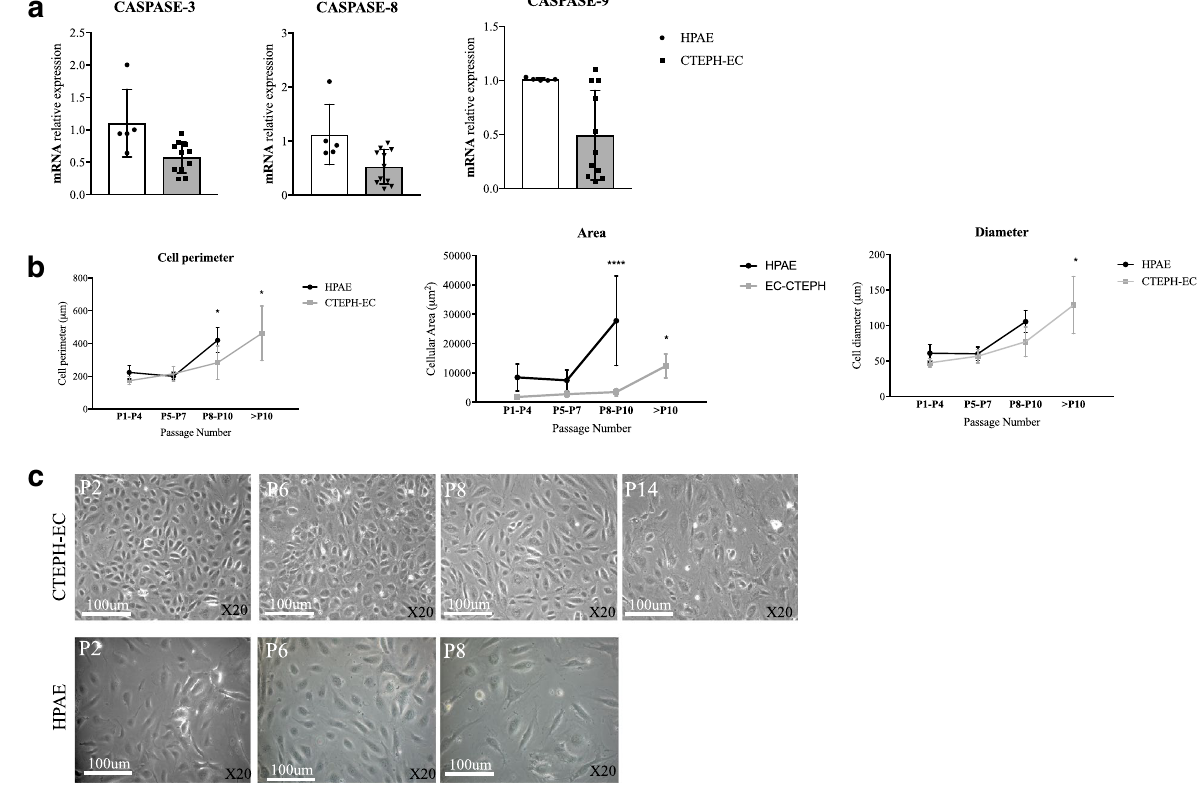
Figure 5. Apoptosis in CTEPH-EC. ( a ) mRNA expression profile of apoptotic markers caspase-3, -8 and -9 in CTEPH-EC compared to HPAE. Values expressed as mean ± SD, n = 5 HPAE, n = 11 CTEPH-EC independent experiments performed in triplicate, p < 0.05*, Mann–Whitney U test. ( b ) Cellular perimeter, area, and diameter of CTEPH-EC and HPAE measured at different passages. Values expressed as mean ± SD, n = 8 HPAE, n = 8 CTEPH-EC independent experiments performed in triplicate. p < 0.05*, p < 0.0001****, two-way ANOVA followed by Tukey´s multiple comparisons test. ( c ) Representative images of CTEPH-EC and HPAE cells at different cell passages. Cellular circumference, area and diameter were measured in triplicate fields of 5–10 cells/picture (20 × magnification) using freely available imaging processing ImageJ software, version:2.1.0/1.53c, http:// imagej. net/ contr ibuto rs. Statistical analysis was performed with GraphPad Prism 7 software, version 7.0e, serial number:GP7-0633739-R###-#####, https:// www. graph pad. com